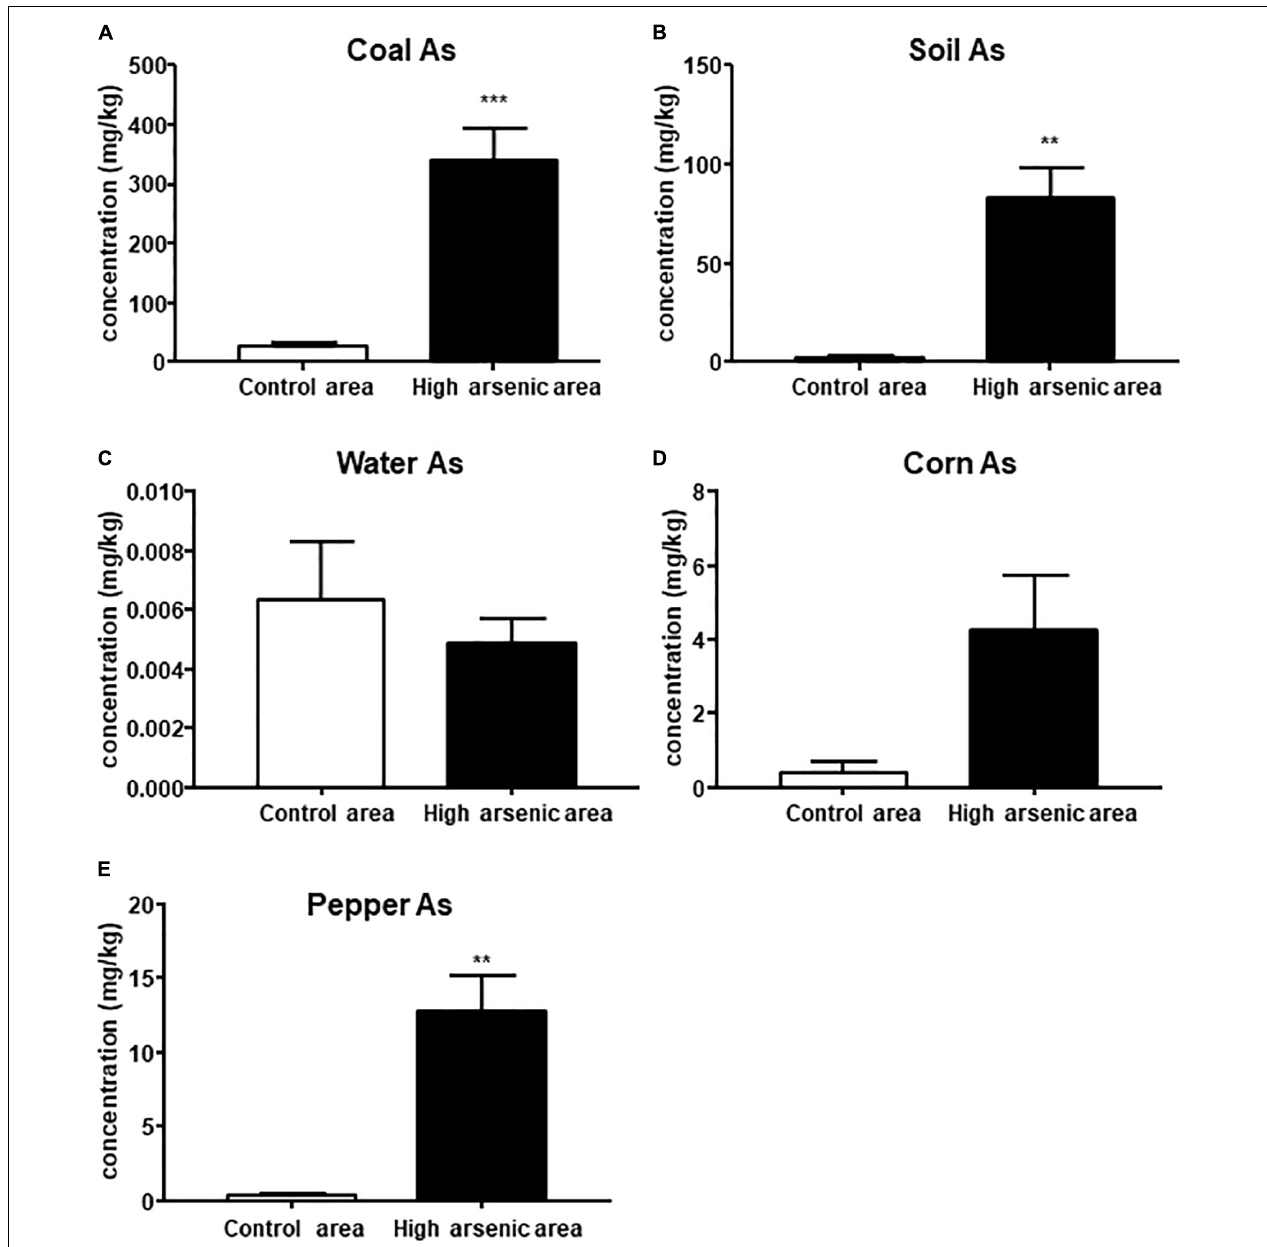
FIGURE 1 | Arsenic content of coal, soil, water, corn, and pepper in Ziyang County and the control area. Data are represented by mean ± SEM. The comparison was performed by t -test. **, *** p < 0.01 and 0.001, respectively.